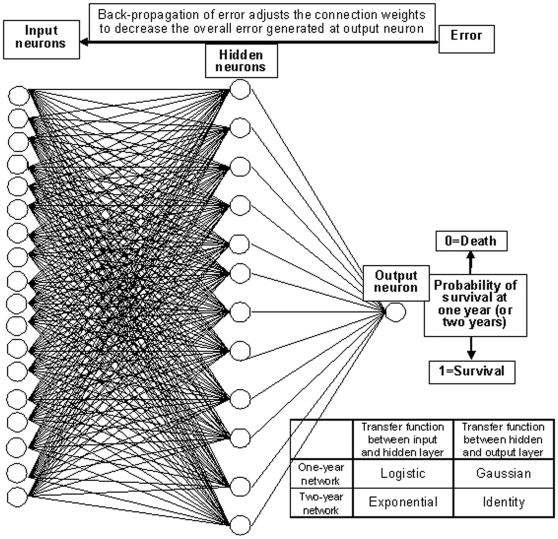
Topological architecture of the MLP network constructed in this study.The network consisted of 18 input neurons, 12 hidden neurons, and 1 output neuron.